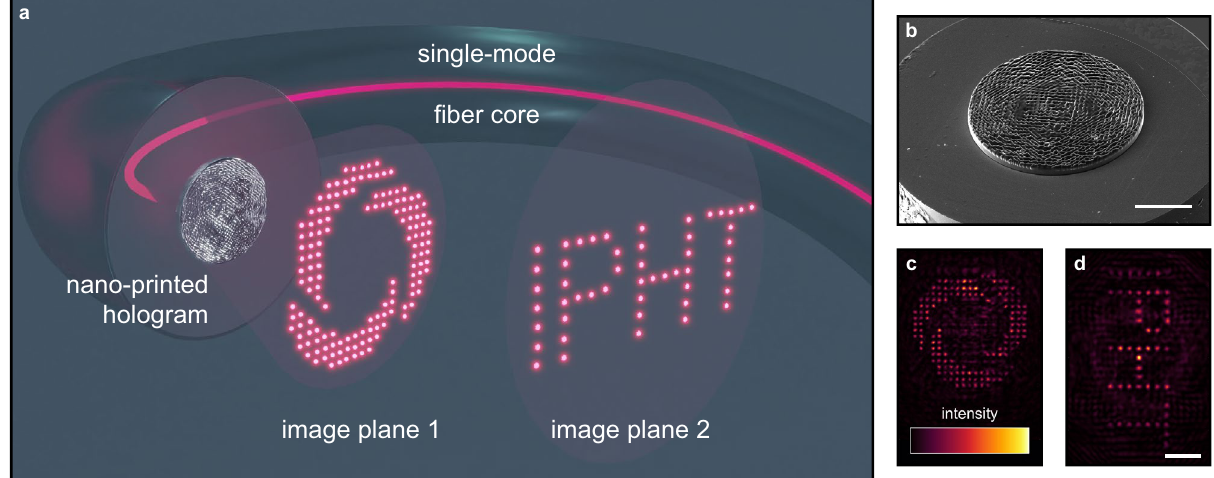
Figure 1. Multi-focus holography on a modified single-mode fiber using a nano-printed phase hologram. ( a ) Scheme of a 3D nano-printed hologram on the end-face of the core of a modified single-mode fiber, together with two multi-focus distributions in two image planes. ( b ) Scanning-electron-micrograph of an example of a nano-printed hologram on the fiber facet (scale bar 20 µm). ( c ) Measured intensity distribution in the first and ( d ) the second focal plane, showing the logo of the Leibniz Institute of Photonic Technology (IPHT) and its lettering (same scale bar (10 µm) for